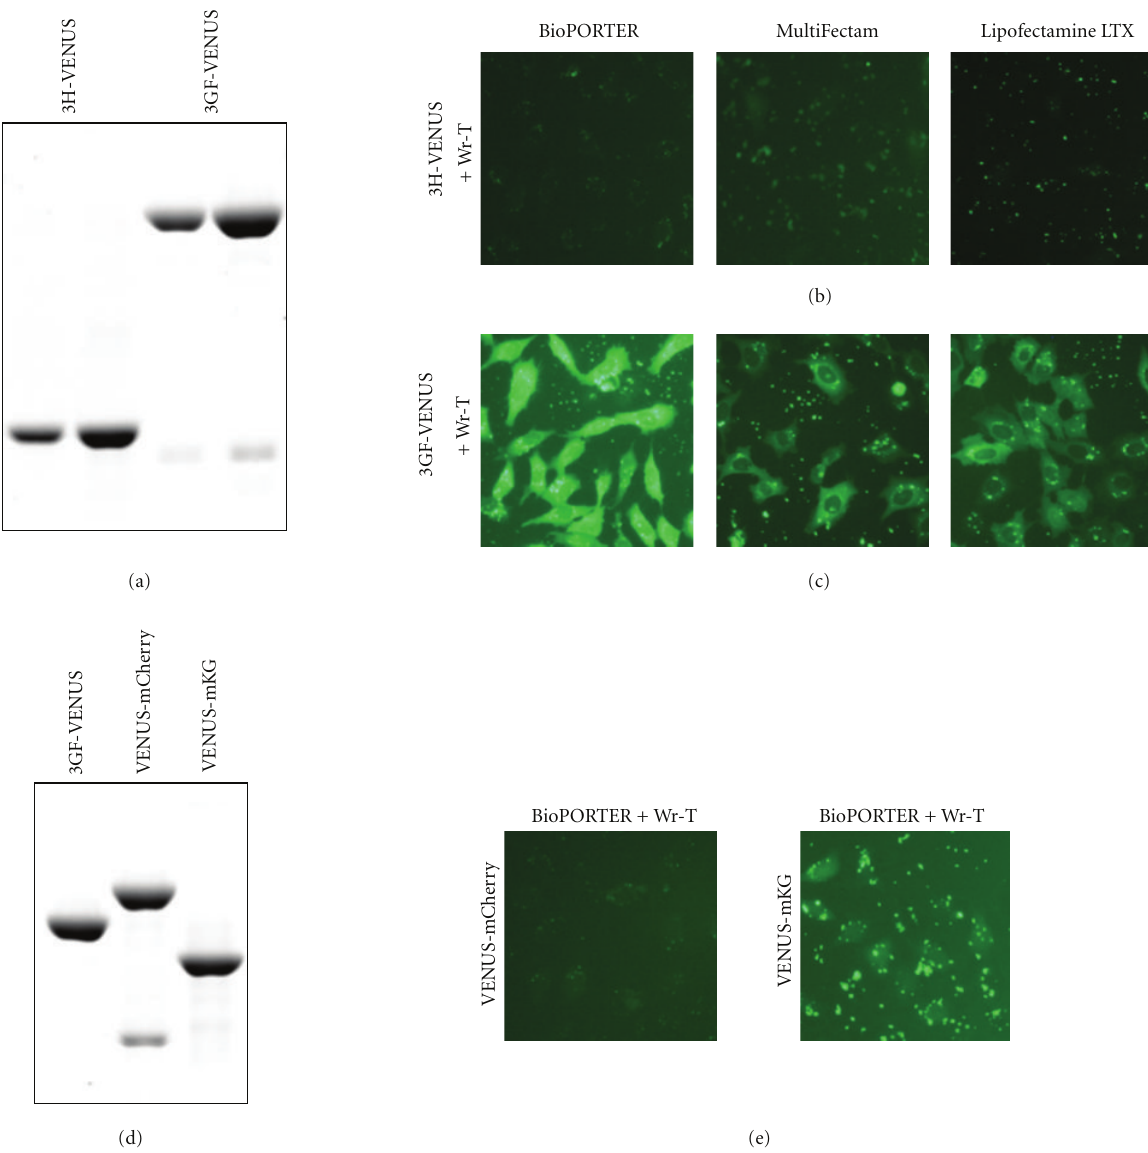
Figure 2: Wr-T/cationic lipid reagents mixture-mediated delivery of VENUS proteins into living cells. (a, c) Following protein purification, 3 (cid:3) His tag-VENUS, 3 (cid:3) GST and FLAG tag-VENUS, 3 (cid:3) mCherry and His tag-VENUS, and 3 (cid:3) mKG and His tag-VENUS were analyzed by SDS- PAGE. VENUS proteins were complexed with Wr-T and cationic lipid reagents and then overlaid onto HeLa cells in a serum-free medium. Cellular localization was monitored at the same exposure time by fluorescence microscopy. (b) 3 (cid:3) His tag-VENUS; (c) 3 (cid:3) GST and FLAG tag-VENUS; (e) 3 (cid:3) mCherry tag-VENUS and 3 (cid:3) mKG tag-VENUS.